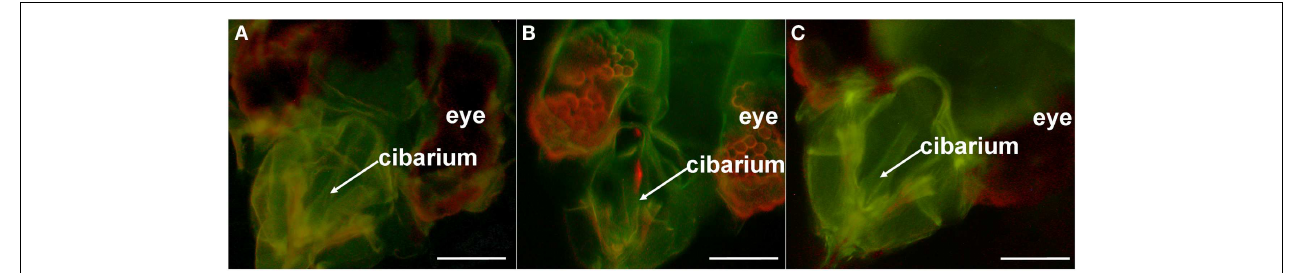
biotinylated-anti-LIYV IgG (B- α IgG), and streptavidin-conjugated QD605 (S-QD 605 ). (C) The dissected head of an unfed biotype A [i.e., it had not fed on artificial diet containing any of the components fed to the whiteflies in (A,B) ]. Locations of the whitefly’s anatomical features (eye and cibarium) are included as points of reference. Bars represent 45 µ